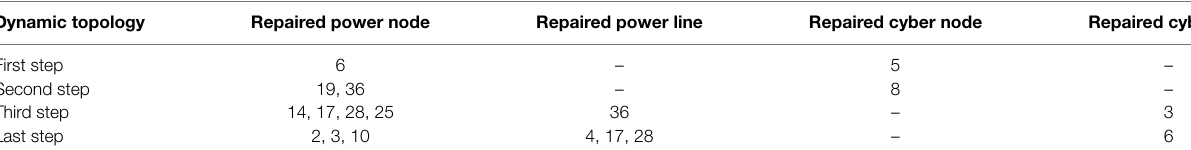
TABLE 3 | Dynamic resilience under hybrid attacks.